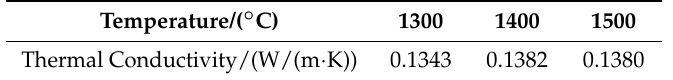
Table 2. High-temperature thermal conductivity of SiBCO aerogel composites under vacuum.